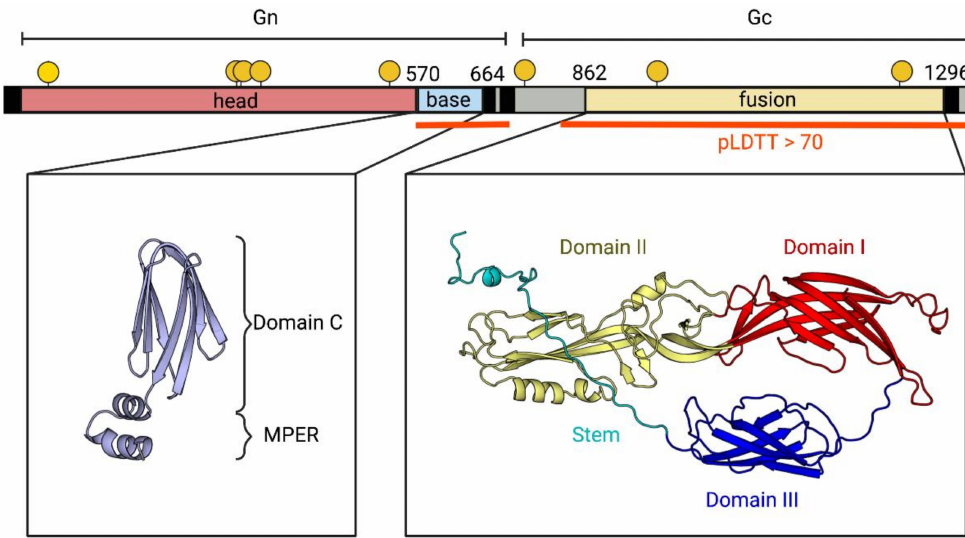
Figure 2. Organization of the glycoprotein. The upper panel shows a diagram of the glycoprotein precursor colored according to domains (Gn H in red, Gn B in cyan, and the class-II fusion protein in yel- low). The boundaries of each domain are indicated on the diagram. The locations of N -glycosylation sites are indicated with a yellow circle on top of the diagram. The two regions that generate a reliable alphafold prediction (pLDTT > 70) are indicated with a red line below the diagram. The panels below show the alphafold predictions for these two regions colored according to domains, as